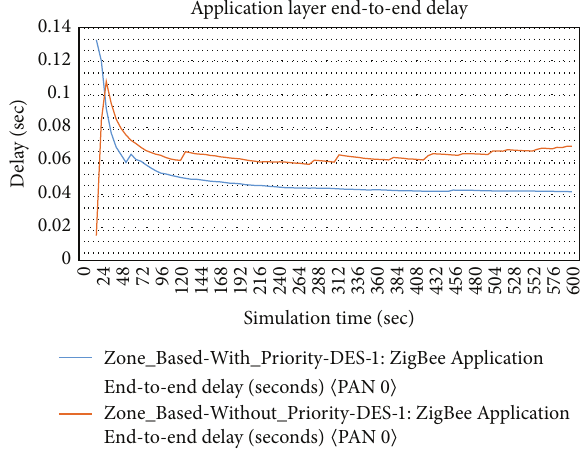
Figure 2: End-to-end delay (sec) for the global